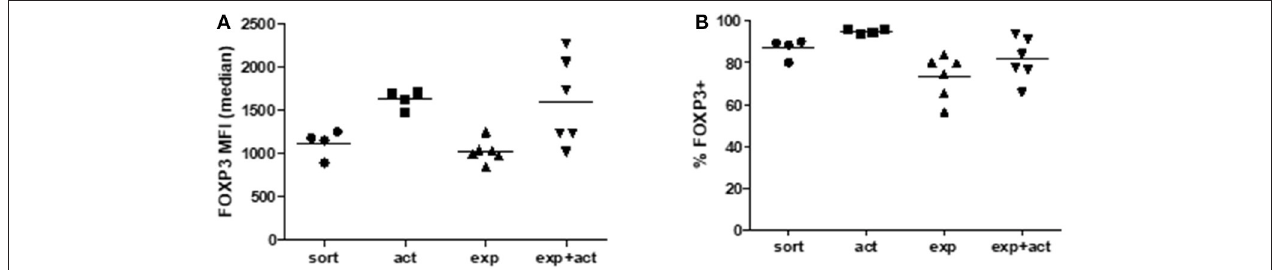
FIGURE 3 | FOXP3 expression in Tregs after activation or expansion. Freshly isolated (sort), transiently activated (act), ex vivo expanded (exp) and transiently reactivated expanded (exp + act) human Tregs were stained for expression of FOXP3 and both (A) Median fluorescence intensity (MFI) and (B) percentage expression of FOXP3 were both measured. n = 4–6 separate donors. Lines indicate mean values. Groups were compared using a non-parametric Kruskal-Wallis ANOVA with Dunn’s post-hoc multiple comparisons